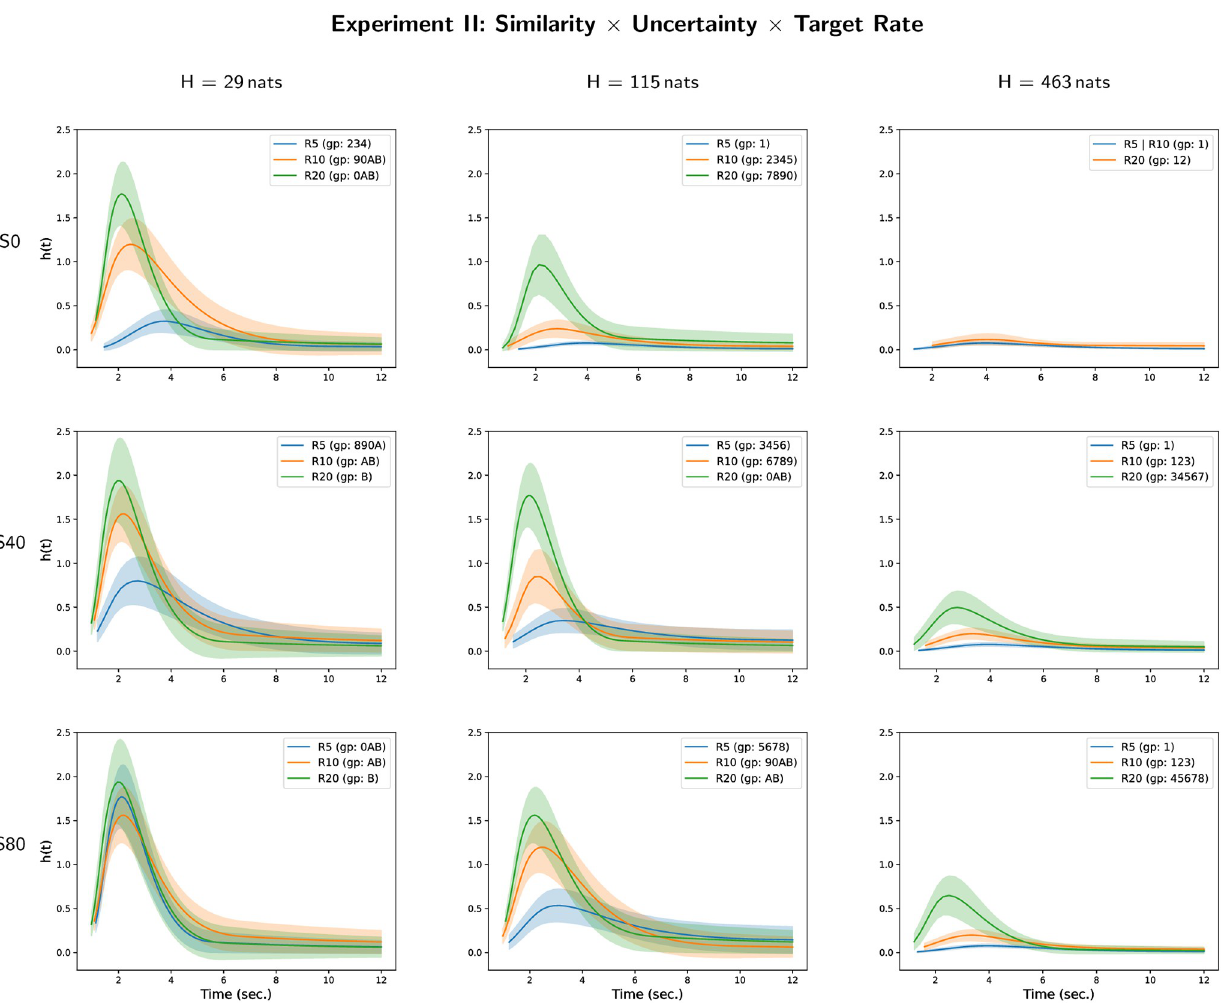
Fig 5. Hazard rate functions h ( t ) for masker uncertainty, masker-target similarity and target repetition rate in Experiment II. Each figure depicts the estimates of the hazard rate functions for each different group of the compact letter display for experimental conditions defined by the interaction between masker uncertainty, masker-target similarity and target repetition